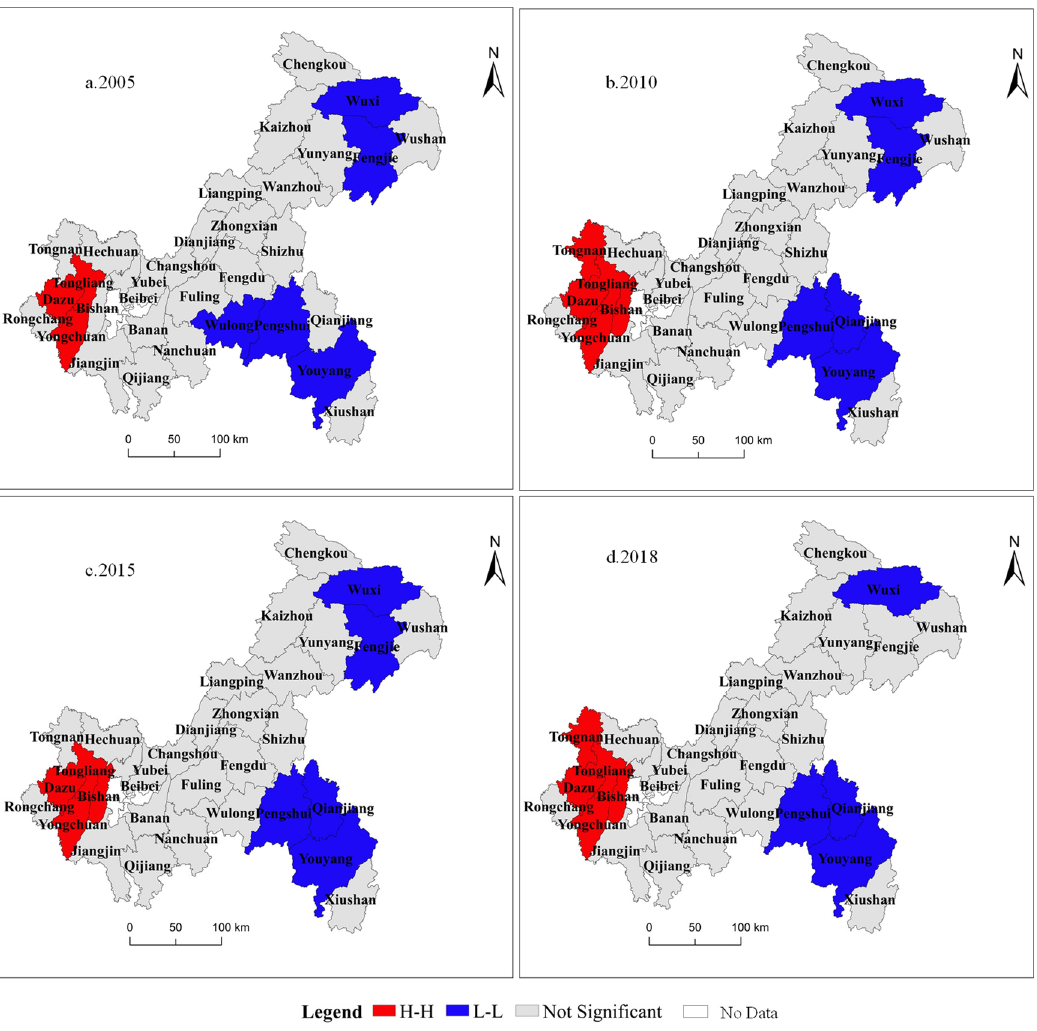
Figure 5. LISA aggregations of the RNCUE values in Chongqing from 2005 to 2018. ( a ) 2005; ( b ) 2010; ( c ) 2015; ( d ) 2018.